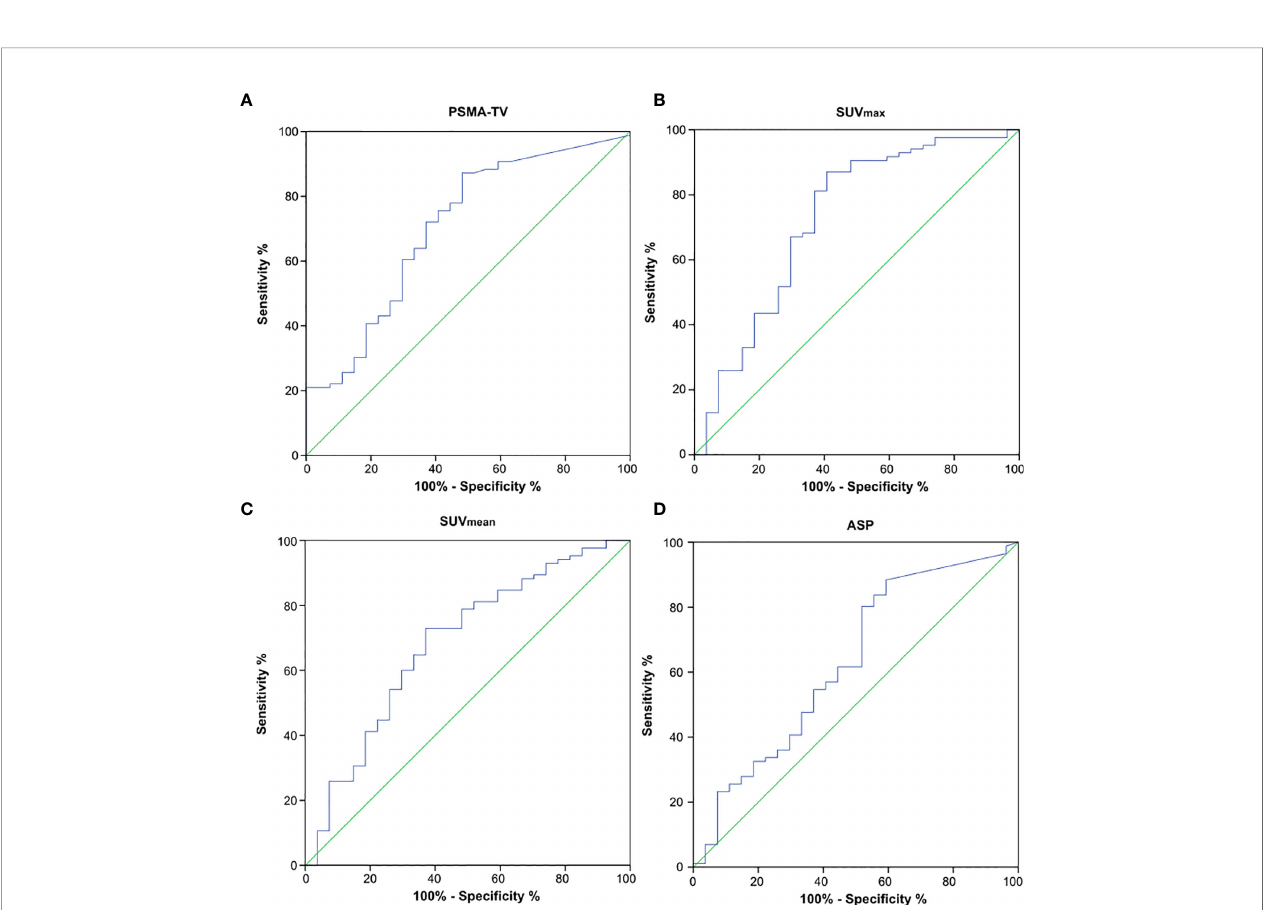
FIGURE 4 | Receiver operating characteristics (ROC) curves to detect high-risk prostate cancer using quantitative PSMA-PET parameters. (A) PSMA-derived tumor volume (PSMA-TV), (B) Maximum standardized uptake value (SUVmax), (C) Mean standardized uptake value (SUVmean) and (D) Tumor asphericity